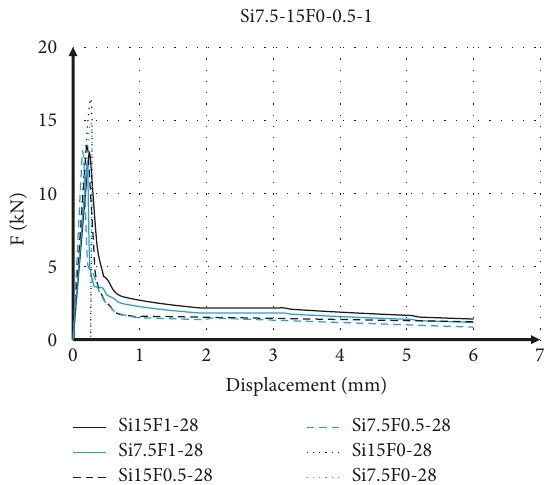
Figure 8: Effect of MPW fiber on flexural behavior of concrete containing silica fume at 28 days.